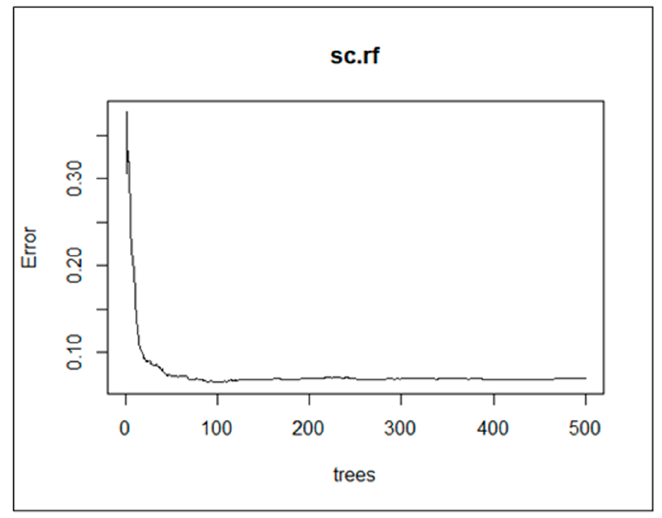
Figure 13. The error vs number of tree graphs for 11 important features. Table 5. Random forest model.